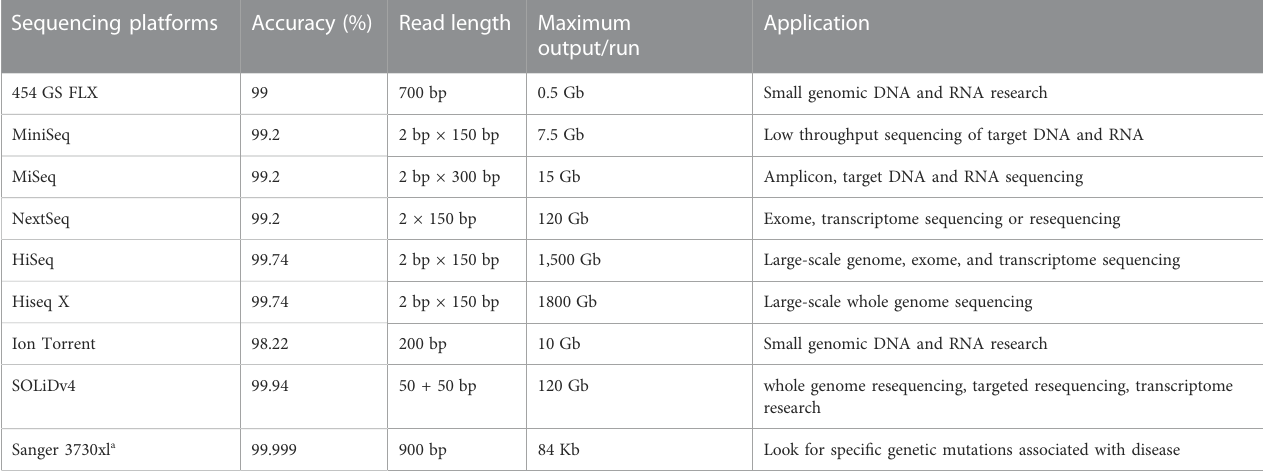
TABLE 1 Comparison of sequencing indexes and characteristics of NGS platforms. Sequencing